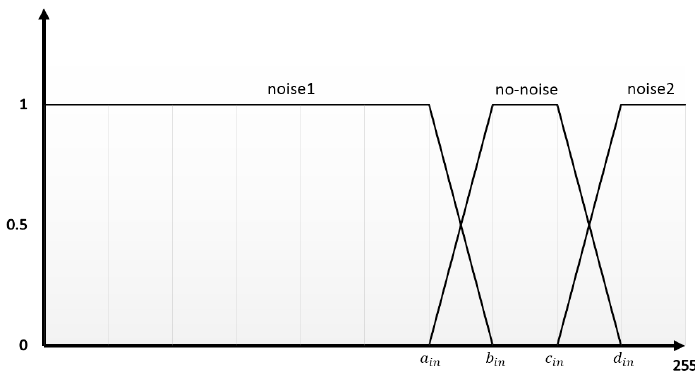
Figure 8. Input attribute function of Figure 7.